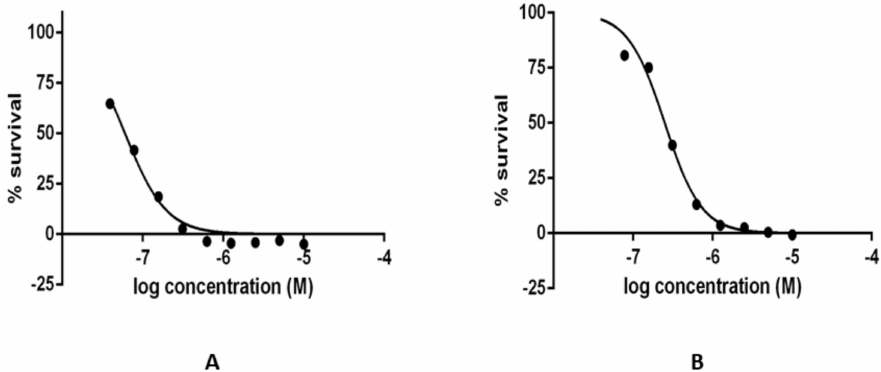
Figure 7. Concetration-dependant leishmanicidal effect in wild type axenic ( A ) proamastigotes and ( B ) amastigotes in L. infantum cultures for compound 15 . Table 3. Results of the leishmanicidal effect measurement of selected hit compounds in the wild-type axenic amastigotes and promastigotes of L. infantum.